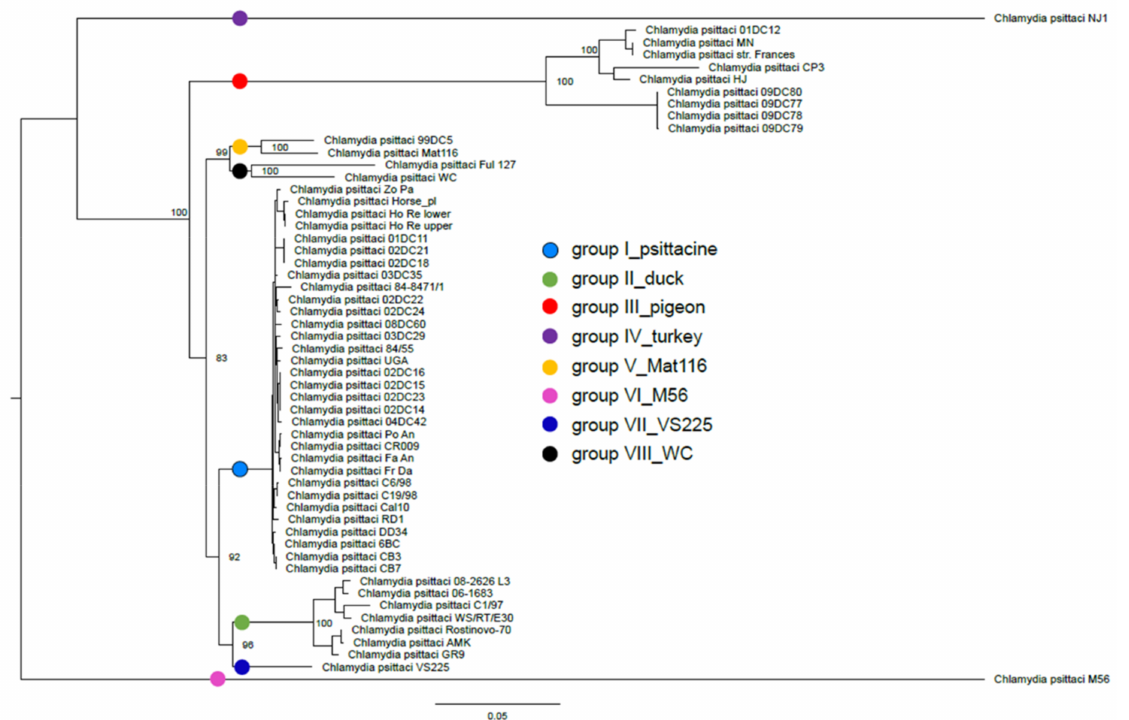
Figure 1. Maximum likelihood SNP-based tree determined from 55 C. psittaci whole genome sequences. The tree was built using RAxML version 8.2.9 with the GTRGAMMA model and 1000 bootstrap replicates. The eight distinct lineages determined in this study (group I_psittacine, group II_duck, group III_pigeon, group IV_turkey, group V_Mat116, group VI_M56, group VII_VS225, and group VIII_WC) are represented by coloured circles. Bootstrap values indicate the stability of the branches and the scale bar represents the number of substitution per